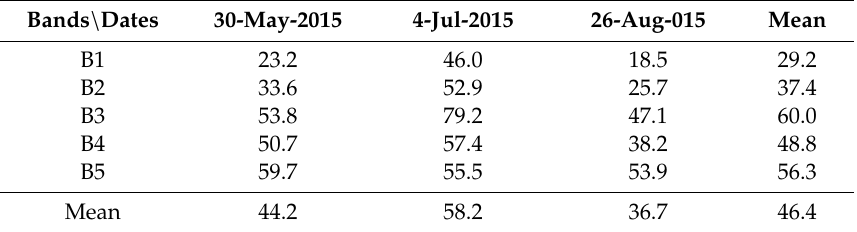
Table 1. Spectral variation (in CV%) of the original RapidEye images per band and date. Bands \